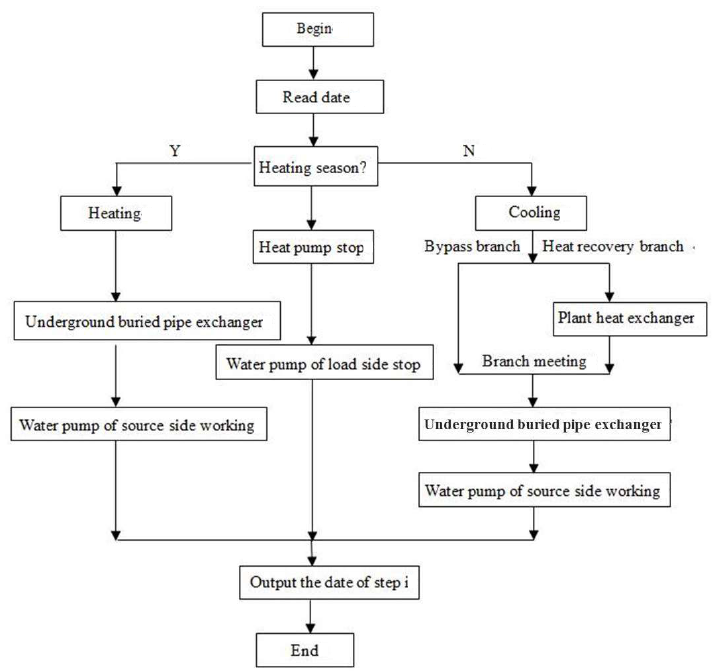
Figure 3. Operation flow chart of the hybrid GSHPS.